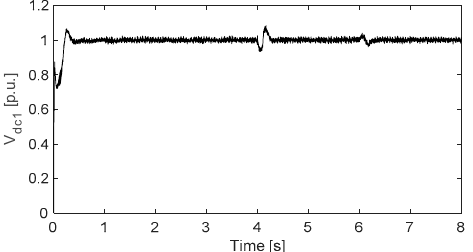
Figure 11. The compensated system response for Vdc1 under the switching-based models of all VSCs in Figure 1.